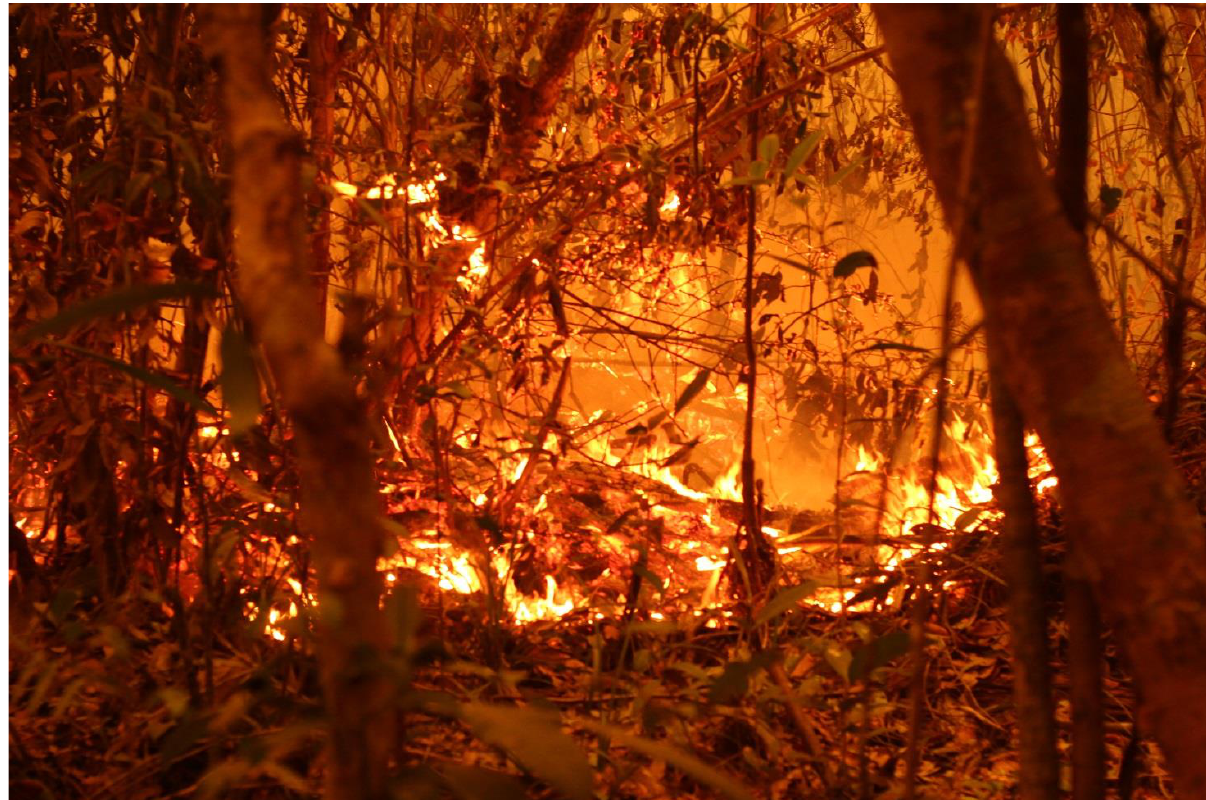
Figure 3. Peat swamp forest on fire. Photo: Alex Allsop /